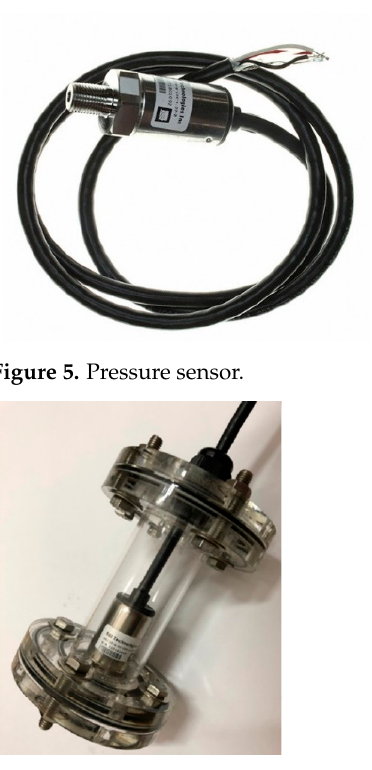
Figure 6. Pressure sensor with the watertight enclosure. Table 2. Technical specifications of the P51 pressure